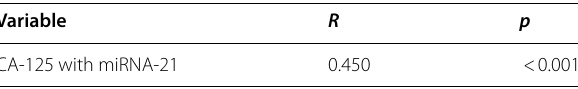
Table 7 Correlation between CA-125 and miRNA-21 among studied groups Variable R p CA-125 with miRNA-21